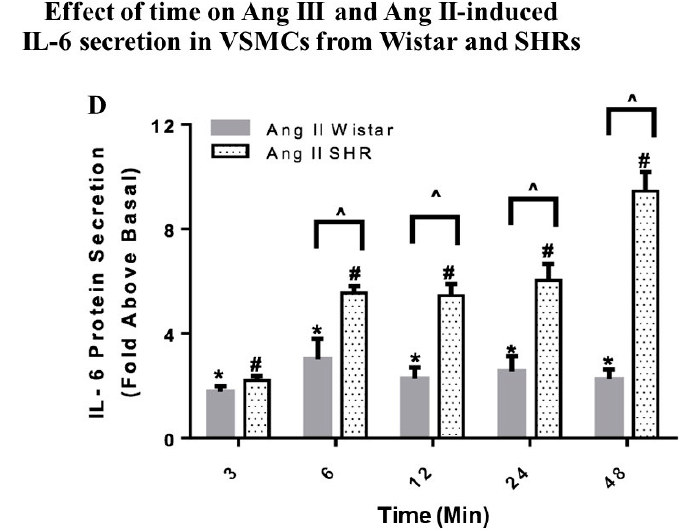
Figure 4. E ff ect of time on Ang II- and Ang III-induced IL-6 secretion in Wistar and SHR VSMCs. Quiescent VSMCs isolated from ( A ) Wistar rats treated with Ang II or Ang III, and ( B ) SHRs treated with Ang II or Ang III were treated with 100 nM Ang II or 100 nM Ang III for 3 h to 48 h. Panel ( C ) compares Ang III-mediated IL-6 secretion from Wistar and SHR VSMCS. Panel ( D ) compares Ang II-mediated IL-6 secretion from Wistar and SHR VSMCs. Secreted levels of IL-6, induced by Ang II and Ang III, were calculated as the fold above basal and were analyzed by an ELISA method. Each value represents the mean ± SEM of preparations of VSMCs isolated from four or more SHRs or Wistar rats. * Denotes p < 0.05 as compared to basal levels of IL-6 secretion in VSMCs treated with Ang III. # Denotes p < 0.05 as compared to basal levels of IL-6 secretion in VSMCs treated with Ang II. ˆ Denotes p < 0.05 as compared between the e ff ects of Ang II or Ang III in stimulation of IL-6 secretion in VSMCs isolated from SHRs versus Wistar rats.